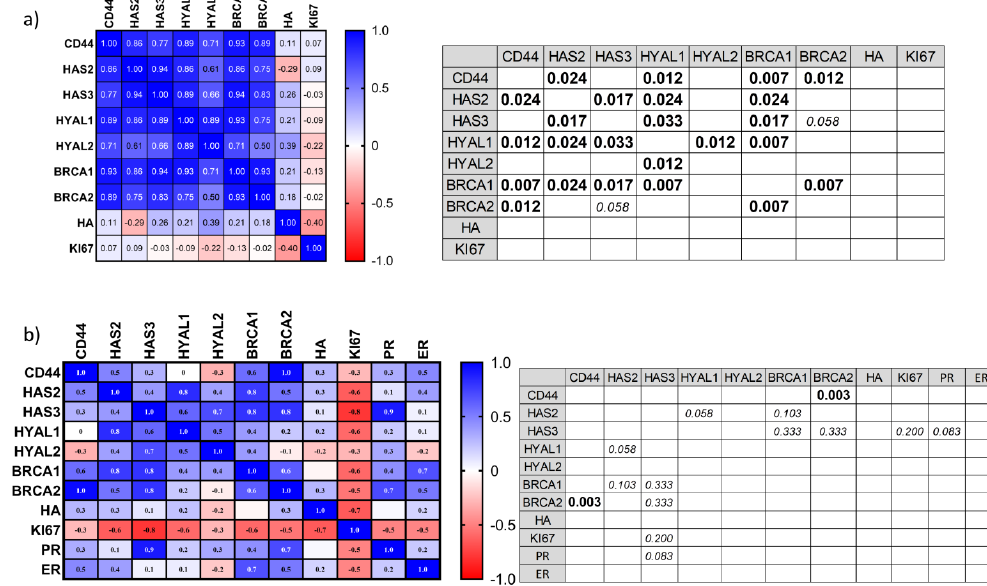
Figure 4. Correlation analysis of colorectal and breast cancer markers. ( a ) The results of correlation analysis for colorectal cancer are shown as a heat map with r values. All r values above 0.8 (or under − 0.8) were considered as a strong correlation (left) and its statistical significance was defined with the p value shown in the table (right). ( b ) The results of correlation analysis for breast cancer are shown as a heat map with r values. All r values above 0.8 (or under − 0.8) were considered as a strong correlation (left) and its statistical significance was defined with the p value shown in the table (right). P -values lower than 0.05 were considered statistically significant and are represented in bold text; P -values higher than 0.05 (with strong correlation result) are represented in italic text.